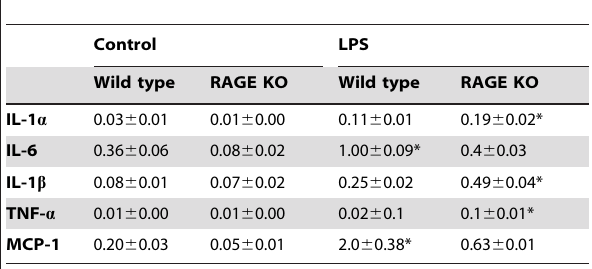
Table 2. Cytokine RNA quantity in lung